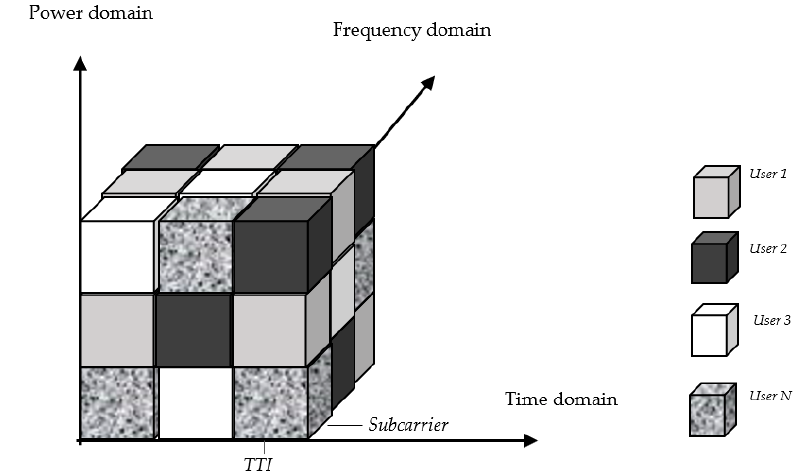
Figure 3. General NOMA resource allocation.